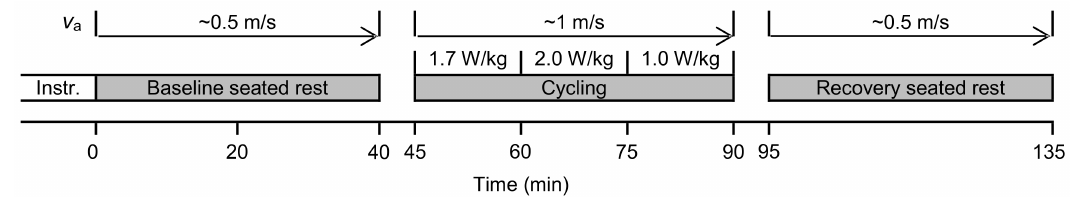
Figure 3. Schematic of the human trial experimental protocol. Minutes 40–45 and 90–95 were used for transitioning between the chair and cycle ergometer and to check for sensor or attachment issues. Intsr., instrumentation; v a , air